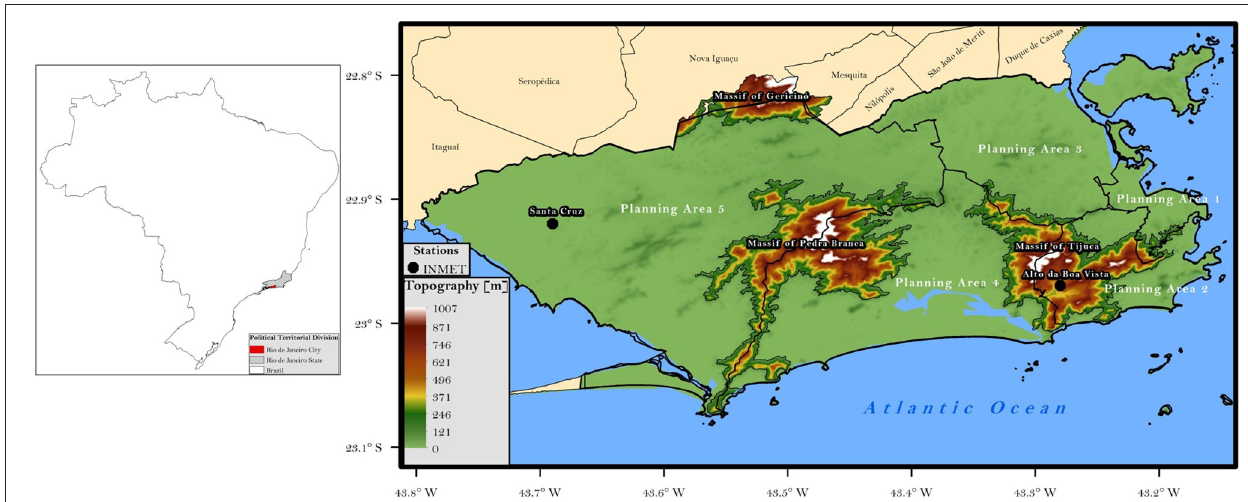
FIGURE 1 | The city of Rio de Janeiro showing its topography, massifs, the five Planning Areas, and the location of INMET’s Alto da Boa Vista and Santa Cruz meteorological stations.